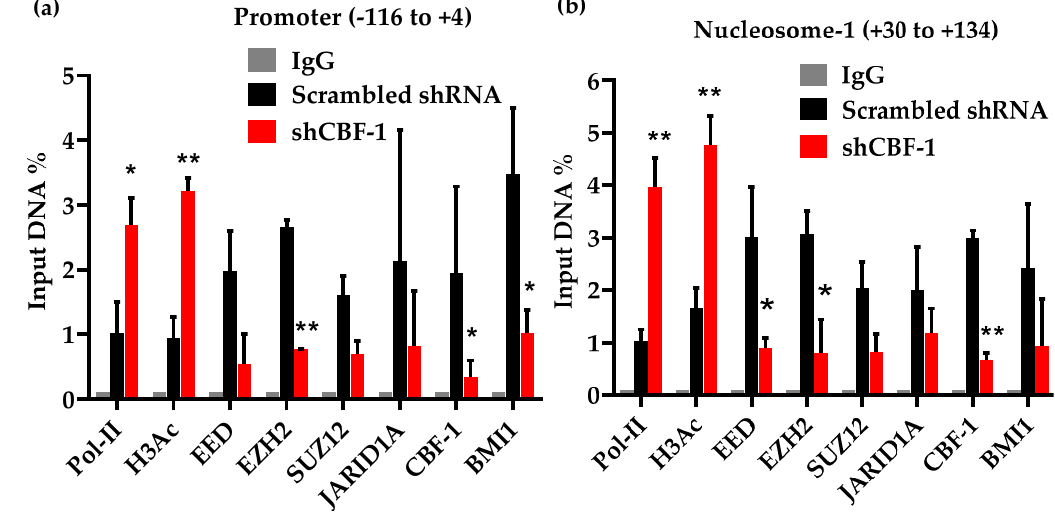
Figure 4. CBF-1 knockdown resulted in dissociation of different factors belonging to both PRCs (PRC1 and PRC2). ChIP analyses were performed using latently infected Jurkat T cells in the absence or presence of CBF-1 knockdown. CBF-1 knockdown leads to the dissociation of various core components of both PRCs, showing the role of CBF-1 in their recruitment at HIV LTR. ( a ) Promoter region ( − 116 to +4); ( b ) Nucleosome 1 (+30 to +134). Error bars represent the SEM of three independent experiments and three separate qPCR measurements from each experiment. Graphs represent the average and standard deviation from three independent and replicate samples. Statistical analysis was calculated with GraphPad Prism 5.0 (GraphPad Software, San Diego, CA, USA). The p value of statistical significance was set at either; p < 0.05 (*) or 0.01 (**).